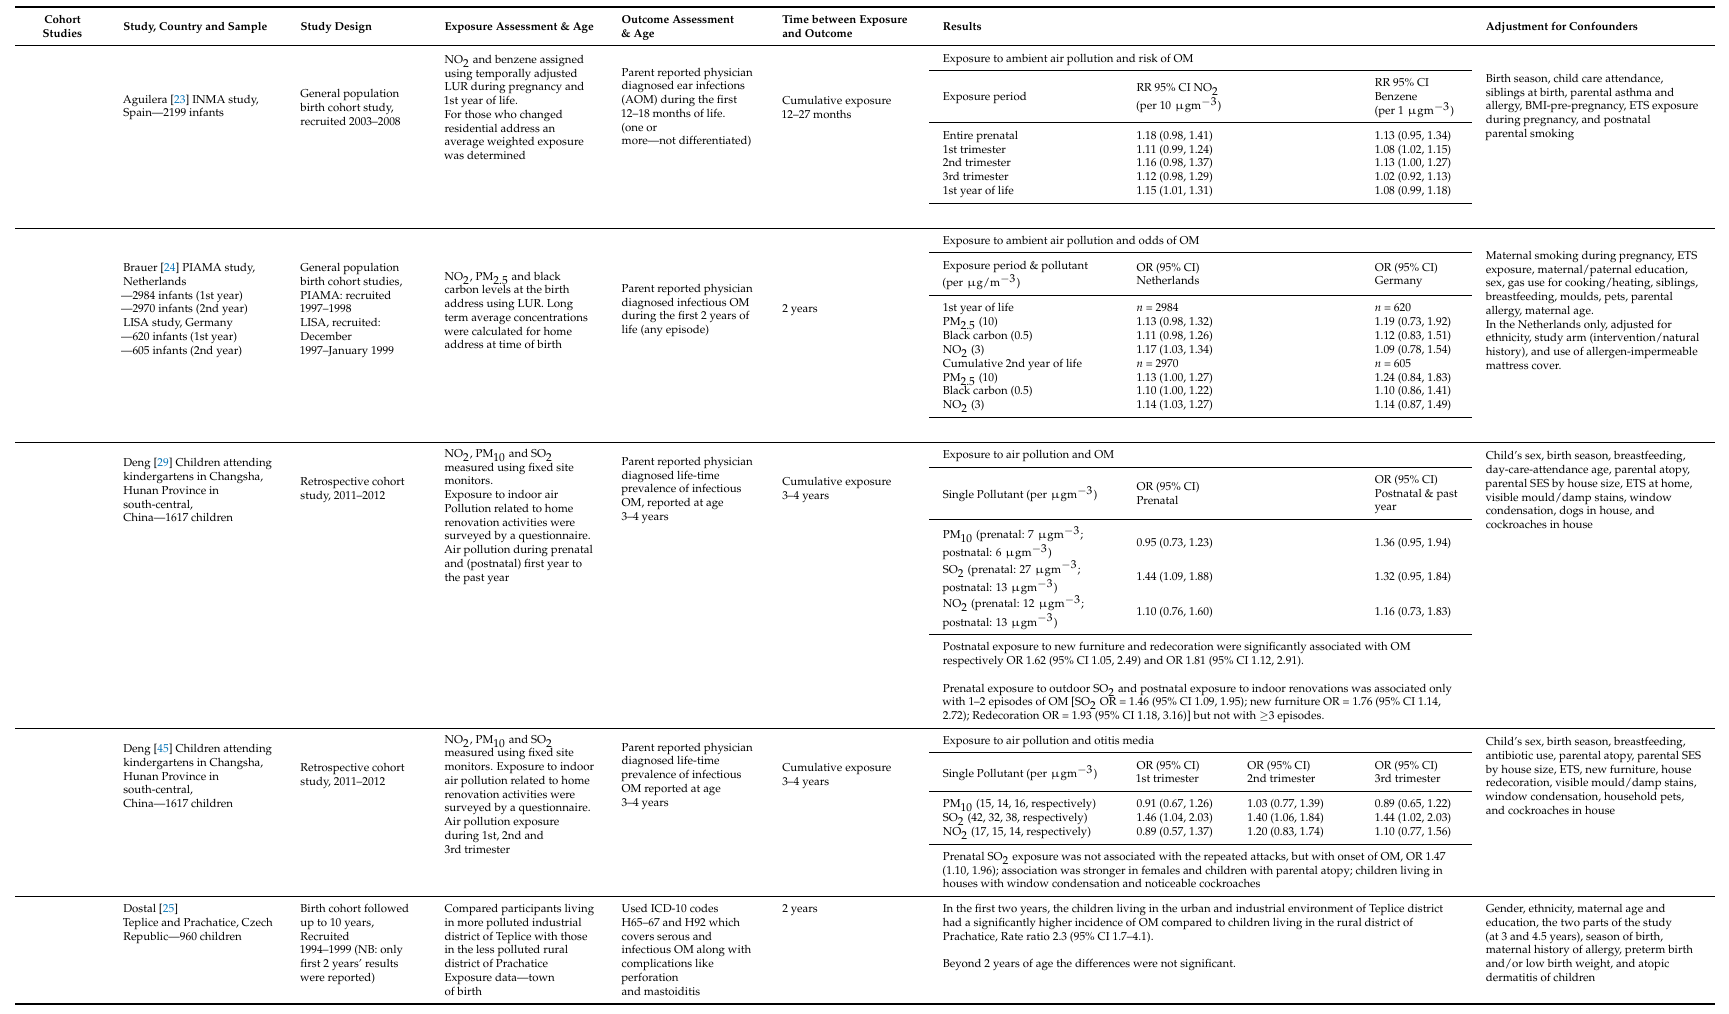
Table 1. Summary of air pollution exposure and otitis media in long-term